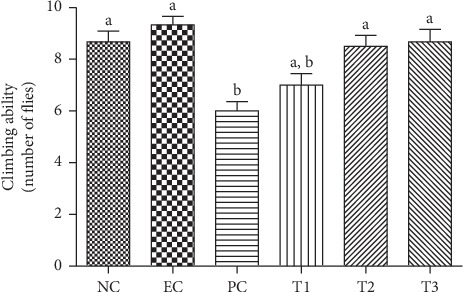
Effect of C. nutans extract on negative geotaxis (10 flies per replicate) in flies exposed to paraquat for 4 days (n = 3). NC: Negative Control (1% sucrose); EC: Extract Control (10 mg/mL extract leaf); PC: Positive Control (3 mM PQ); and treatment: (T1 = 3 mM PQ + 1 mg/mL extract; T2 = 3 mM PQ + 5 mg/mL extract; T3 = 3 mM PQ + 10 mg/mL extract). Different letters represent statistical differences according to Tukey's test (p < 0.0001).